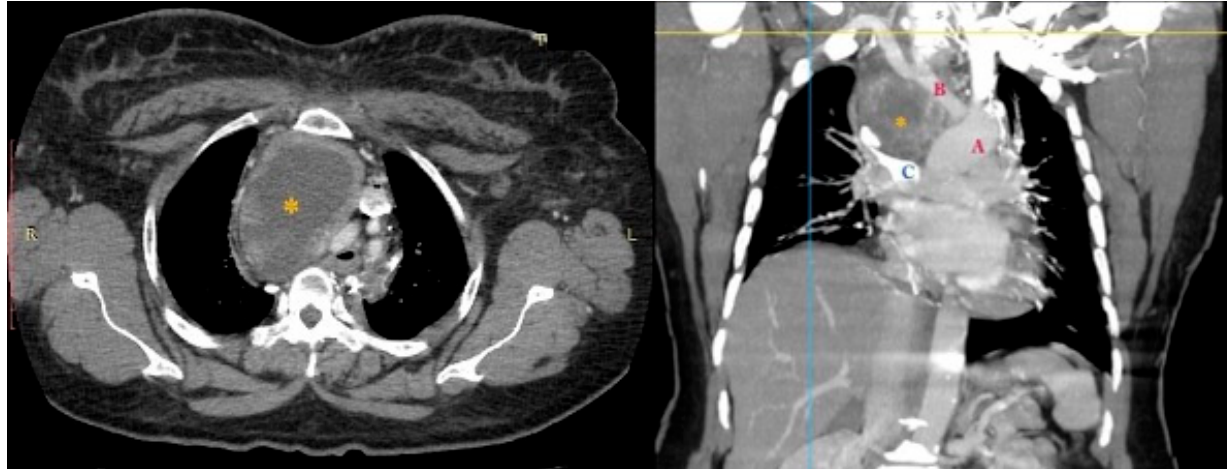
Figure 2. CECT showing large central necrotic lesion measuring 8.4 × 6.1 × 8.2 cm involving the superior mediastinum, displacing the trachea to the left, and compressing the brachiocephalic veins and the proximal SVC. * necrotic lesion.